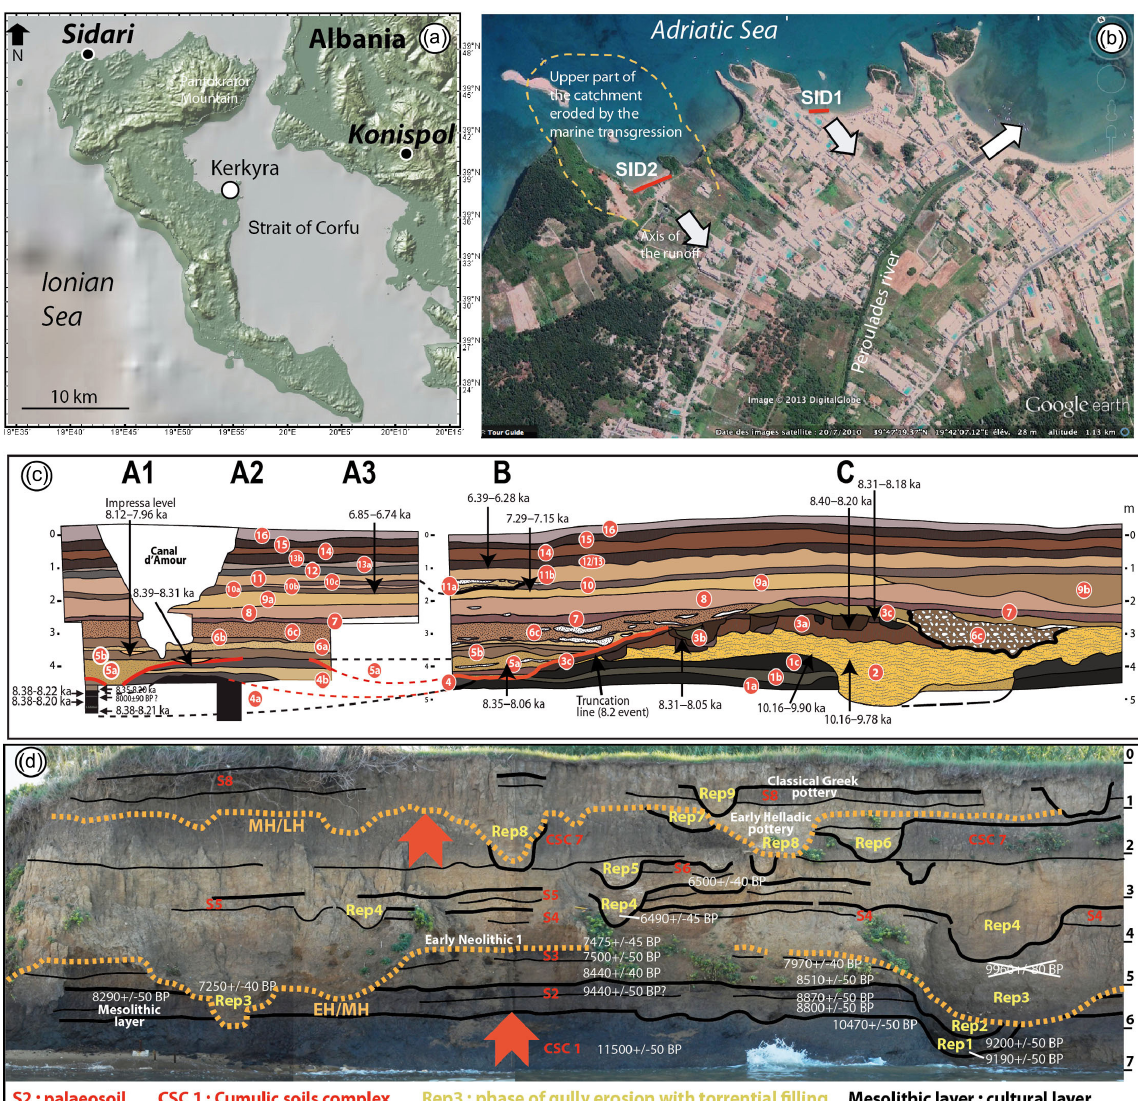
Figure 7. (a) Map of Corfu with location of the site of Sidari on the northern coast; (b) location of the Sidari 1 and 2 trenches in two small marly valleys, tributaries of the Peroulades River; (c) pedo- and chronostratigraphic contexts of the Sidari 1 sequence with the main Neolithic levels (after Berger et al., 2014); and (d) pedo- and chronostratigraphic contexts of the Sidari 2 sequence with the main Holocene lithostratigraphic